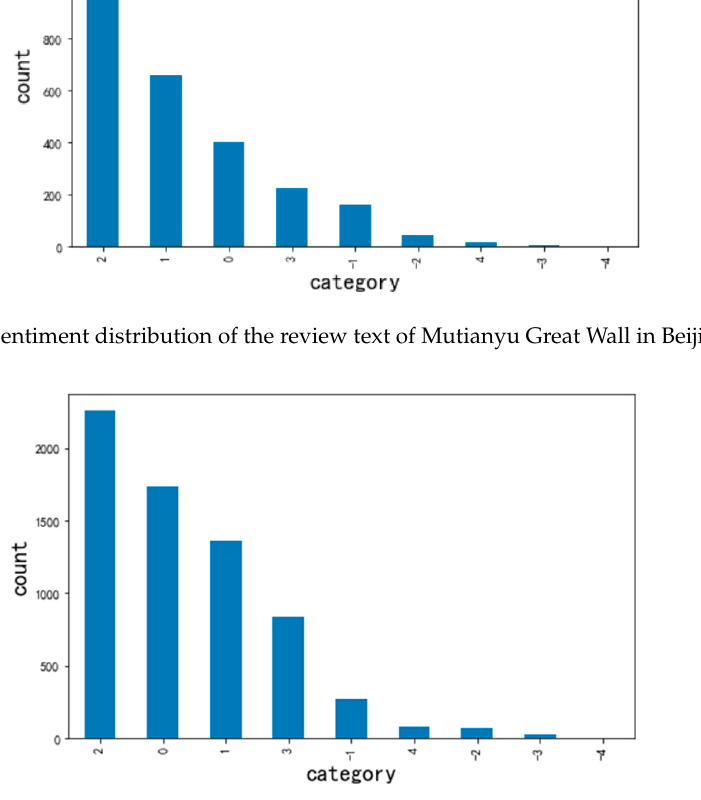
Figure 8. The sentiment distribution of the review text of the Harry Potter Wizarding World Theme Park in Orlando, USA.